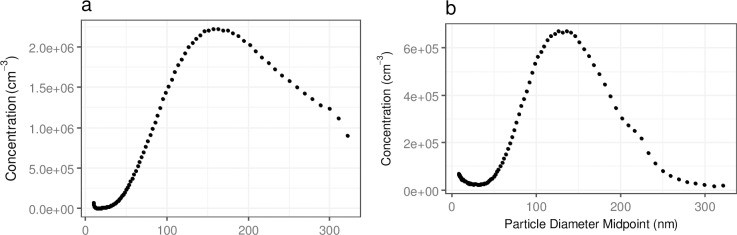
Particle size distributions as measured by the SMPS for a) Cigarette smoke particles b) Petrol exhaust particles. The respective number size distributions for different times were aggregated to the total size distribution.